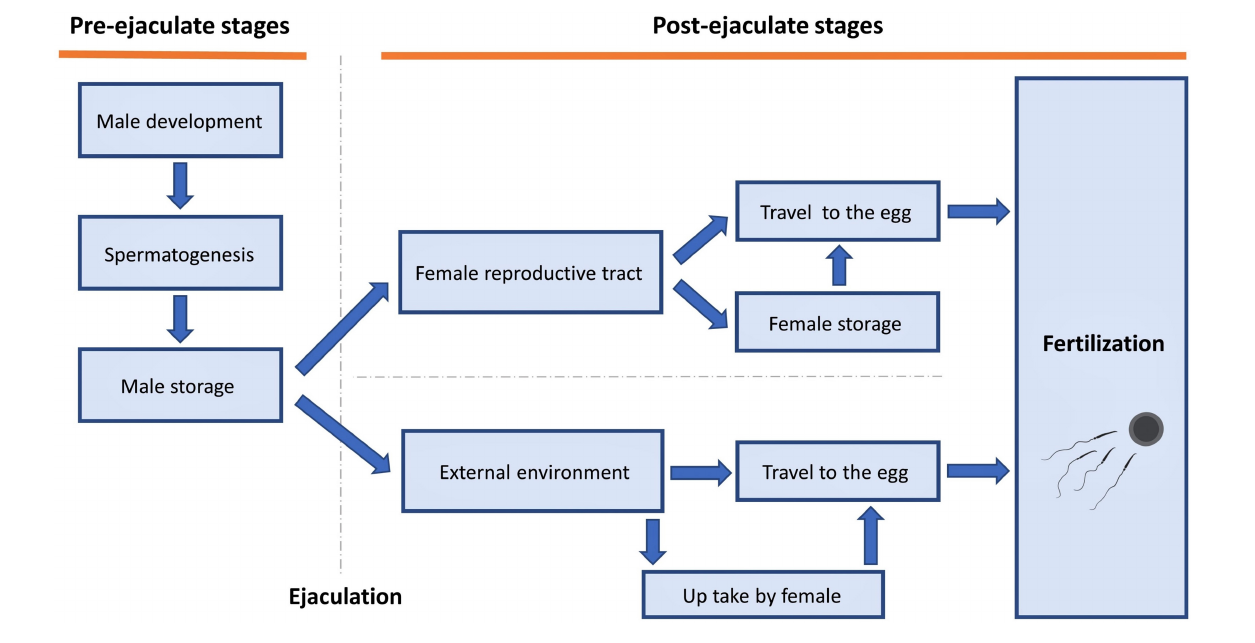
FIGURE 2 | Stages at which temperature could impact sperm